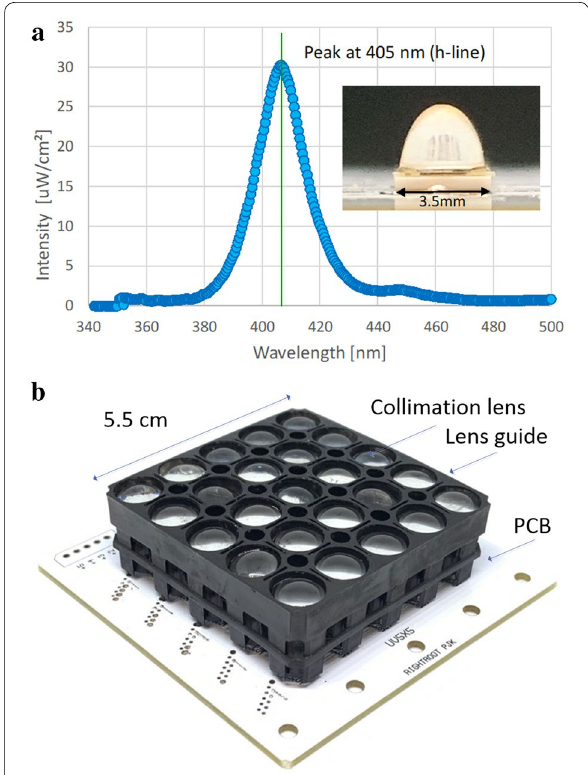
Fig. 3 LED light source, a 405 nm LED spectrum (inset: the SMD led), b assembled light